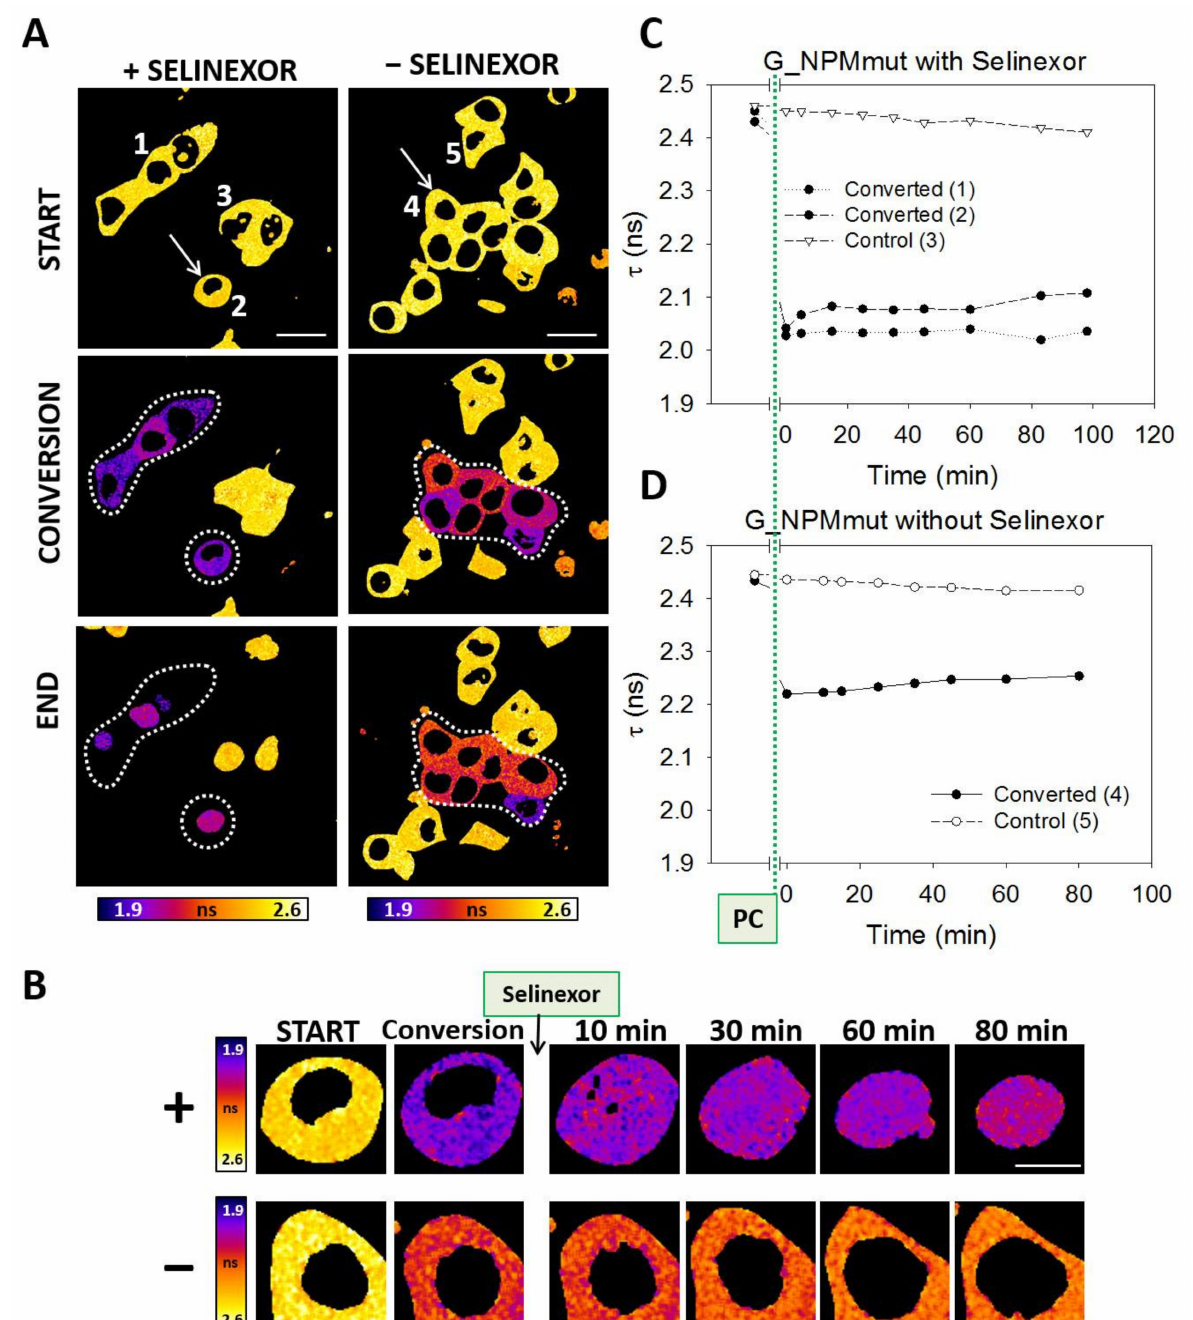
Figure 6. Effect of Selinexor on localization and lifetime of G_NPMmut in live HEK-293T cells. ( A ) Lifetime images of G_NPMmut in the presence and absence of 4 µ M Selinexor before (the 1st row), immediately after (the 2nd row) and 80 min after the photoconversion (PC) (the 3rd row). The photoconverted area is bordered by the dashed line. Bar represents 20 µ m; ( B ) detailed time evolution of G_NPMmut lifetime maps in single cell with photoconverted eGFP in the presence (upper row, cell no. 2) and in the absence (lower row, cell no. 4) of Selinexor. The visualized cells are marked by arrows in panel A. The nuclear signal was negligible in the absence of Selinexor. A minute increase in τ GFP is noticeable both in the presence and absence of Selinexor. Bar represents 10 µ m; ( C , D ) time evolution of τ GFP in the photoconverted cells (1, 2, 4) and in control cells (3, 5) in the presence ( C ) and absence ( D ) of Selinexor. Cells used for integration of the plotted signal are marked in the panel A. Abbreviations can be found in Table 1. Representative results from 3–5 repeated experiments are